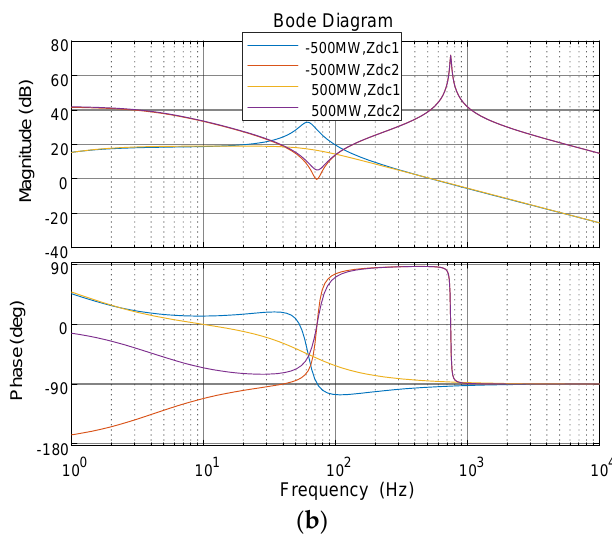
Figure 8. ( a ) Nichols plots of T m when transmission power is ± 500 MW. ( b ) Impedance frequency responses of Z dc 1 and Z dc 2 when transmission power is ± 500 MW.